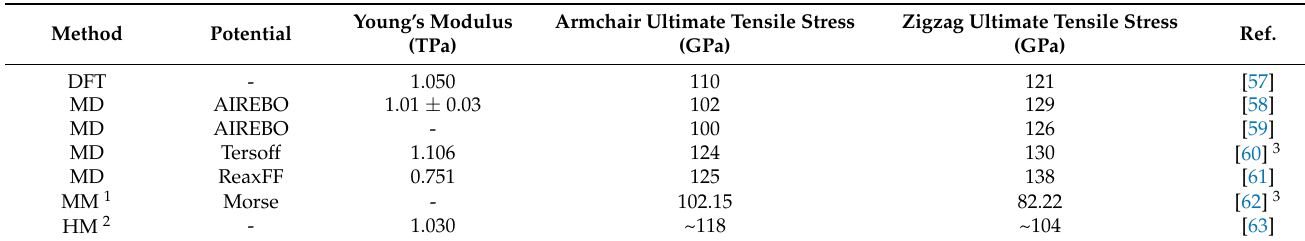
Table 1. The Young’s modulus and Cauchy ultimate strength of defect-free graphene obtained from different methods.